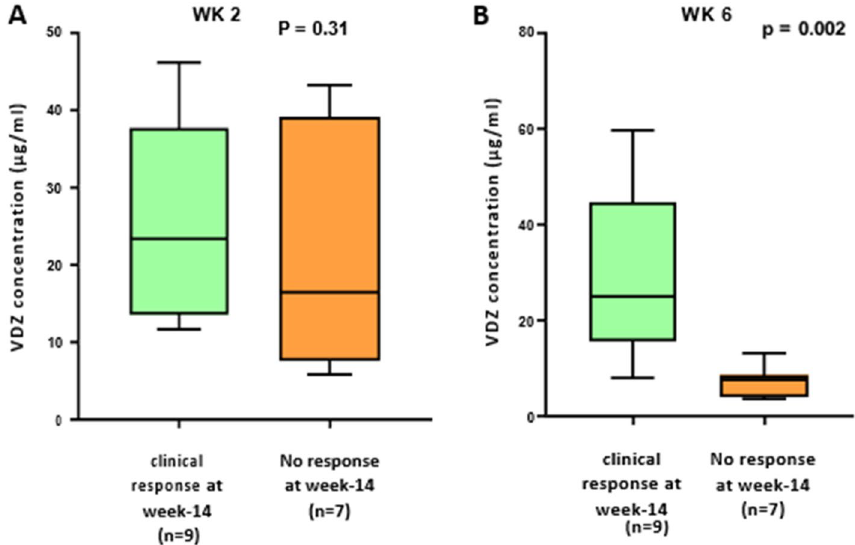
Figure 3. A box plot at week 14 showing the trough level of vedolizumab was categorized based on clinical response. ( A ) Patients with a response at week 14, along with patients with no response, were categorized based on their vedolizumab trough levels from week 2. ( B ) Patients with a response at week 14, along with patients with no response, were separated into two groups based on trough levels at week 6. P values Mann–Whitney